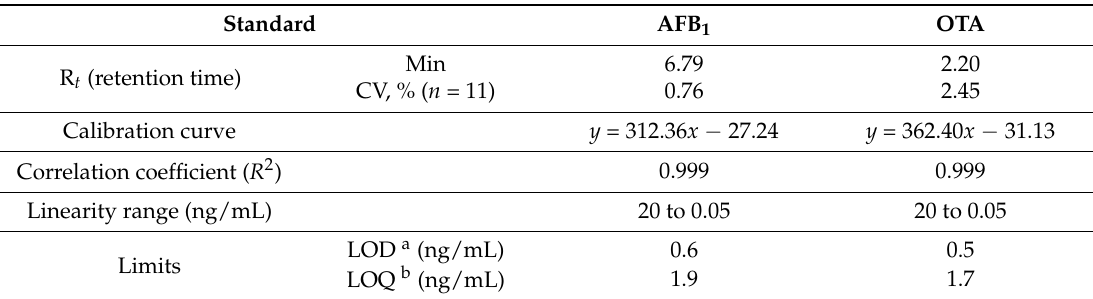
Table 3. Calibration parameters of instrumentation for aflatoxin B1 and ochratoxin A detection and quantification. Standard AFB 1 OTA Min